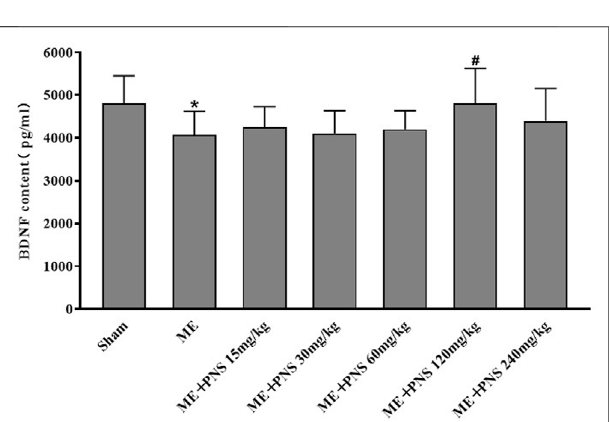
FIGURE 3 | PNS administration promoted BDNF protein levels in the serum of ME rats. Expression level of BDNF was measured by ELISA and data were presented as means ± standard deviation, n = 8 in sham and ME, n = 7 in other groups. * p < 0.05, ** p < 0.01 versus Sham group; # p < 0.05, ## p < 0.01 versus ME